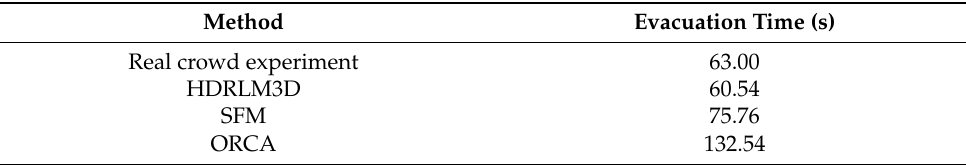
Table 4. Evacuation times of different methods.